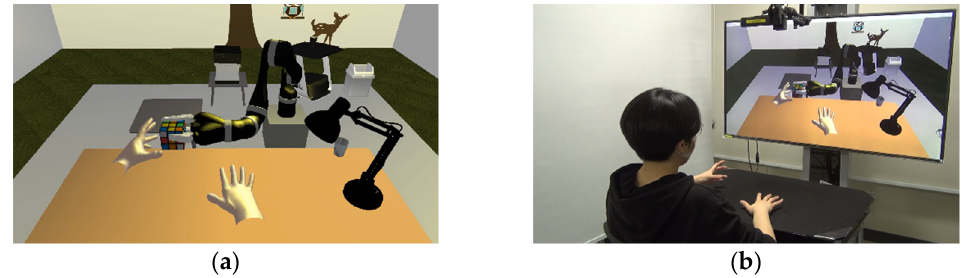
Figure 3. VR smart office: ( a ) robots provide service to user and ( b ) experimental setup.